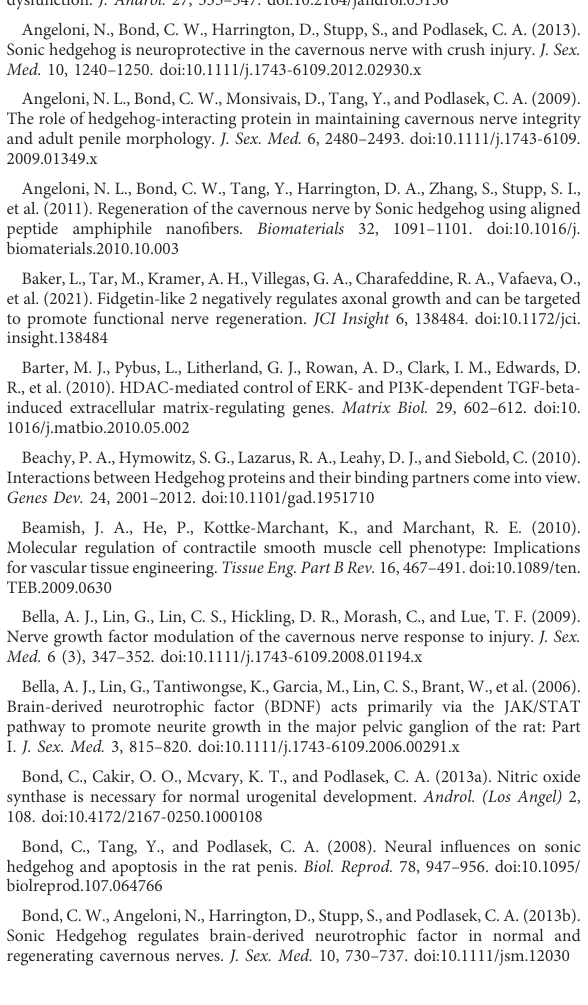
fi ndings indicate that the future is bright and patients are expected to no longer suffer from ED after